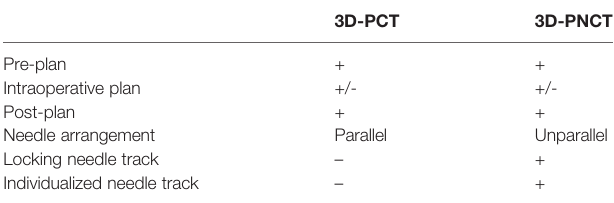
TABLE 3 | 3D-PCT and 3D-PNCT